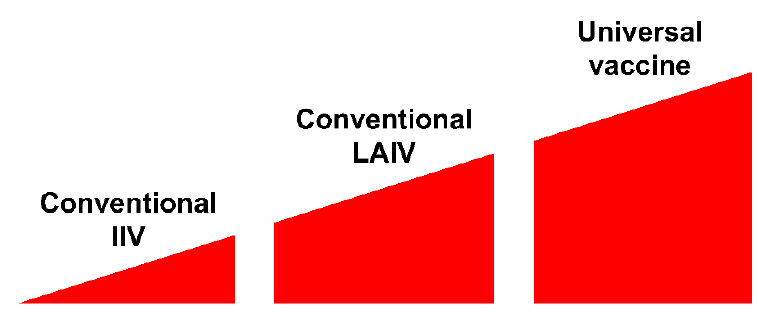
Figure 2. Cross ‐ protective efficacy of different types of influenza vaccine. Figure 2. Cross-protective e ffi cacy of di ff erent types of influenza